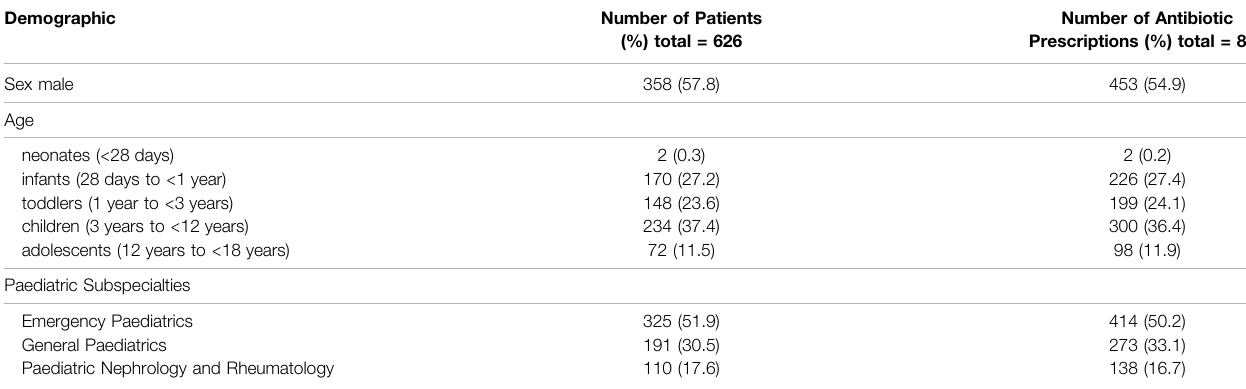
TABLE 1 | Demographic characteristics of patients and antibiotic